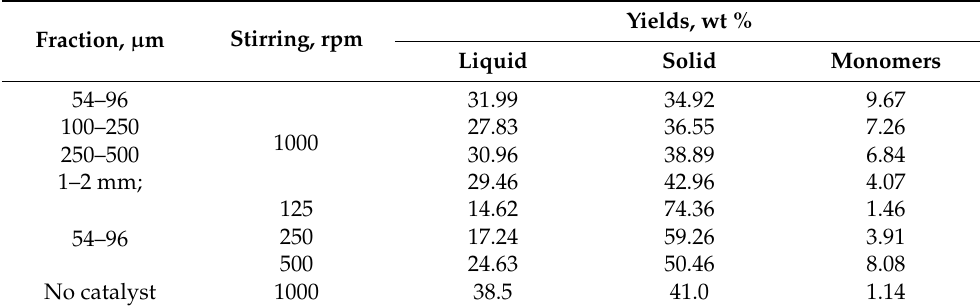
Table 10. Effect of the stirring rate and catalyst grain size on the composition of the products from the fractionation of flax shives (10NiS450, 225 ◦ C). Yields, wt % Fraction, µ m Stirring, rpm Liquid Solid